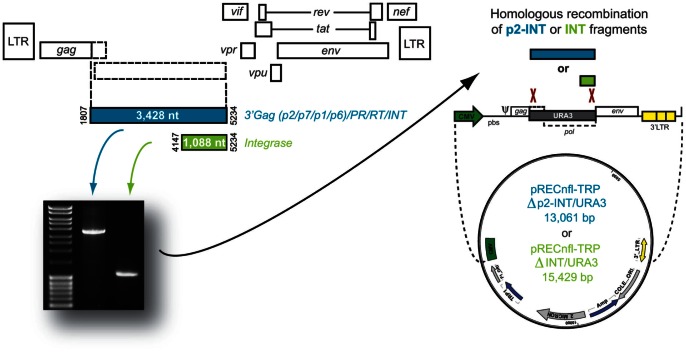
Strategy to introduce patient-derived gag-p2/NCp7/p1/p6/pol-PR/RT/IN or IN PCR fragments into a proprietary vector via yeast homologous recombination as described [49].